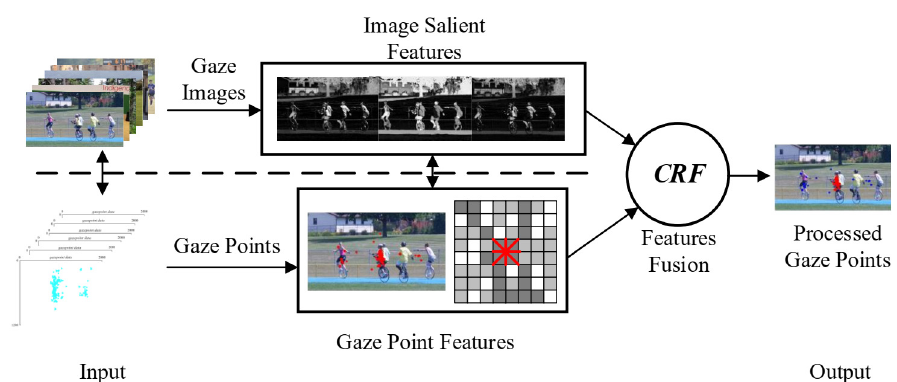
Figure 1. The process of gaze point classification.